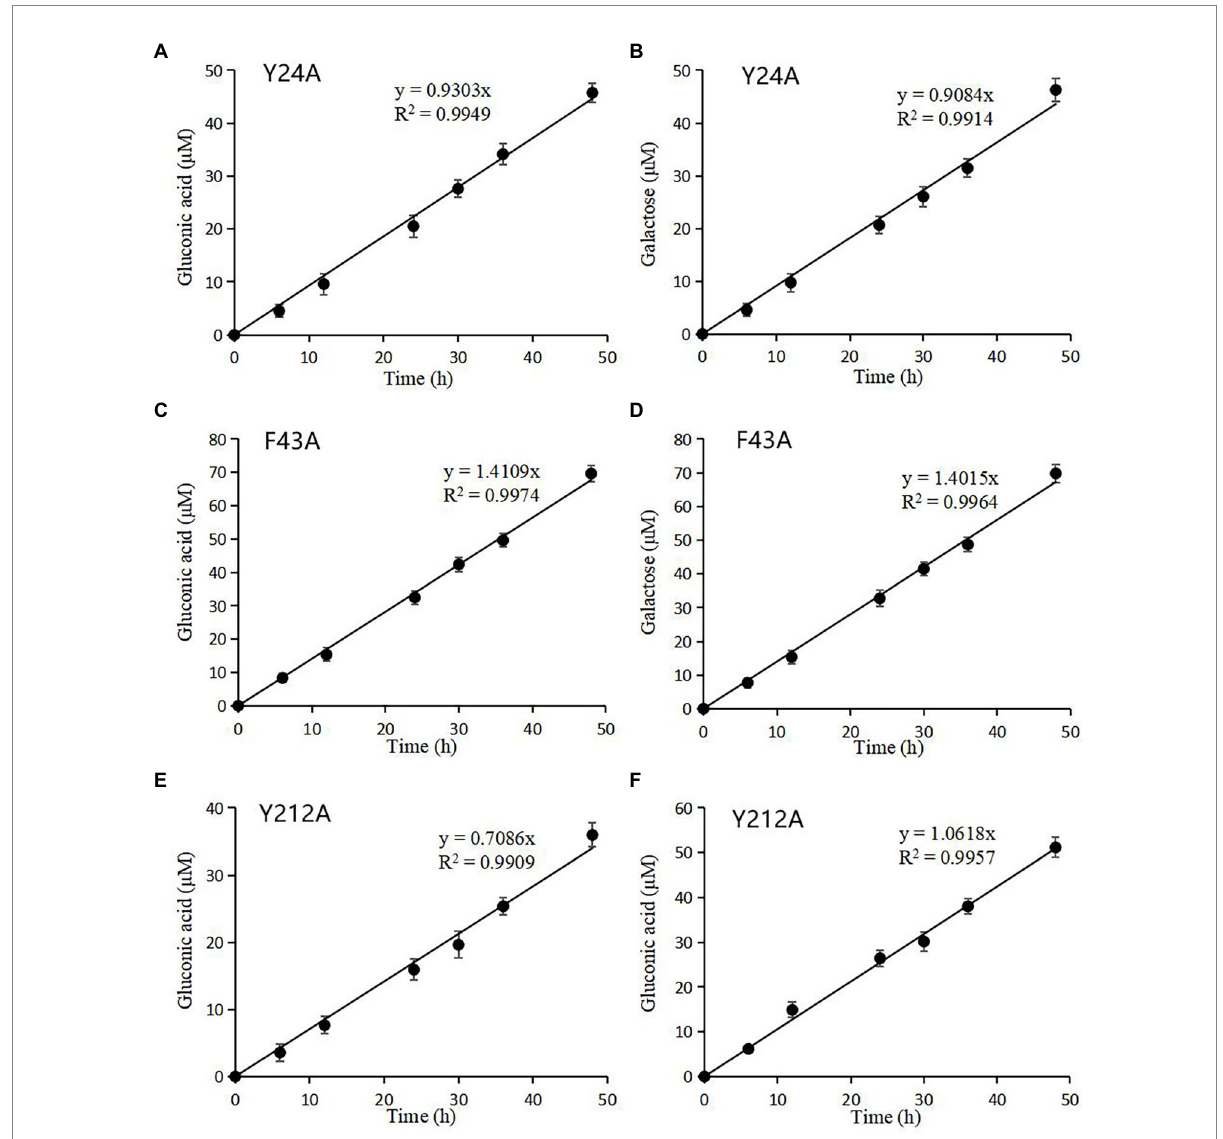
FIGURE 8 Quantification of mutated rTaAA9A reaction products by HPLC-RID analysis. Y24A (A) , F43A (C) , and Y212A (E) reaction products were hydrolyzed by TFA; then, gluconic acid was quantified using HPLC-RID. Y24A (B) , F43A (D) , and Y212A (F) reaction products were reduced by NaBH 4 followed by hydrolysis with TFA and then quantified by HPLC-RID for galactose. All experiments were performed in three replicates, and error bars indicate the standard